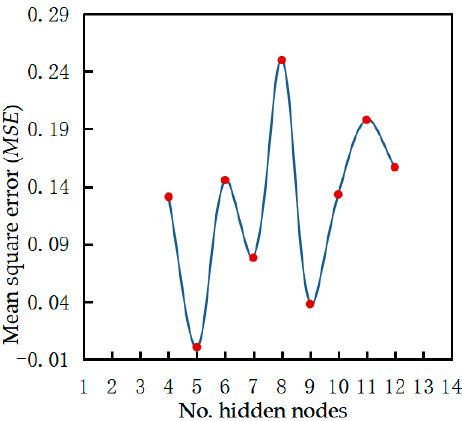
Figure 7. Performance of artificial neural network models with different hidden layer nodes (learning rate = 0.1 and training goal = 0.001).